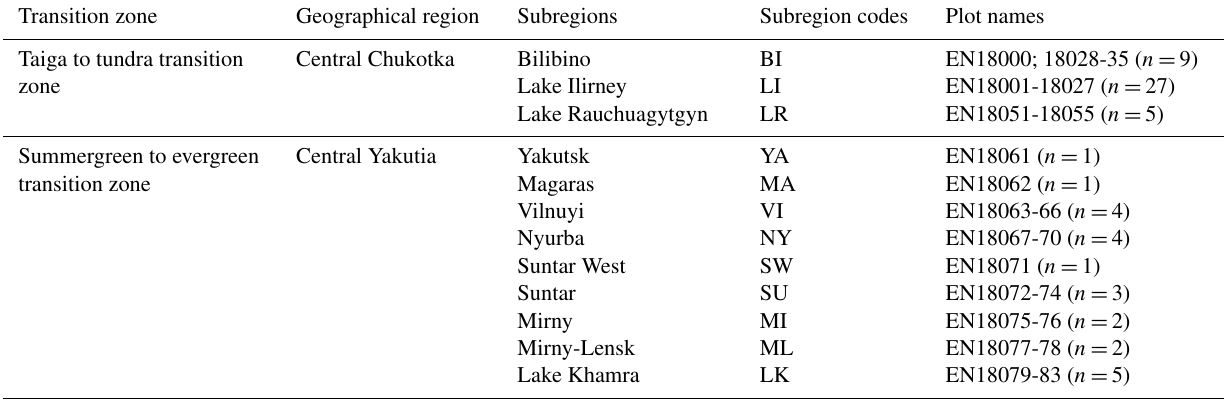
Table 1. Overview of vegetation plots per transition zone, region, and subregion along with the subregion codes. Transition